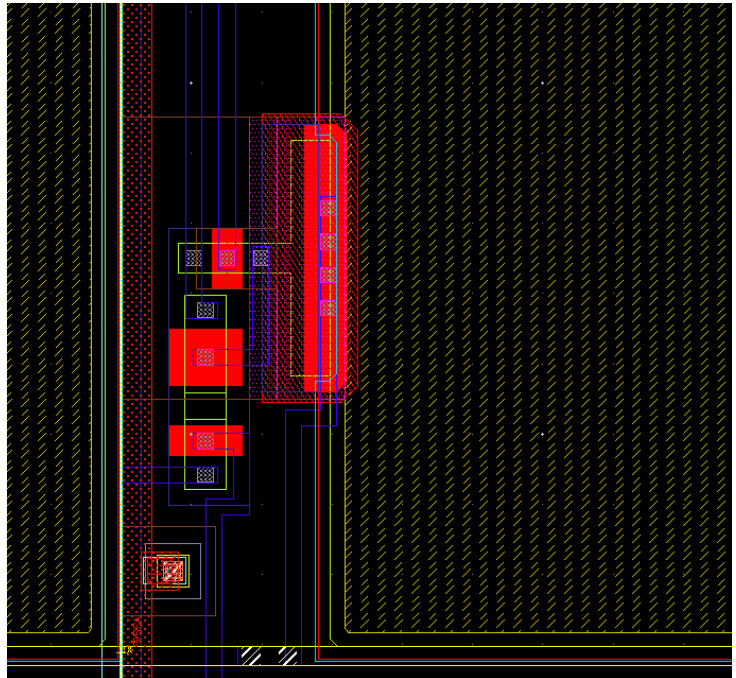
Figure 6. Layout portion of the fabricated 105 μV/e− CG pixel layout, whose circuitry is based on Figure 4 4T pinned-pixels.